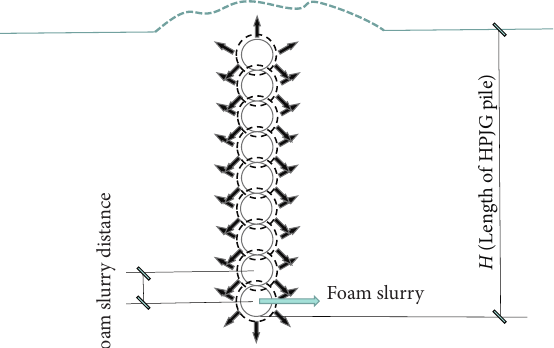
Figure 2: The superposition simulation of the foam slurry during